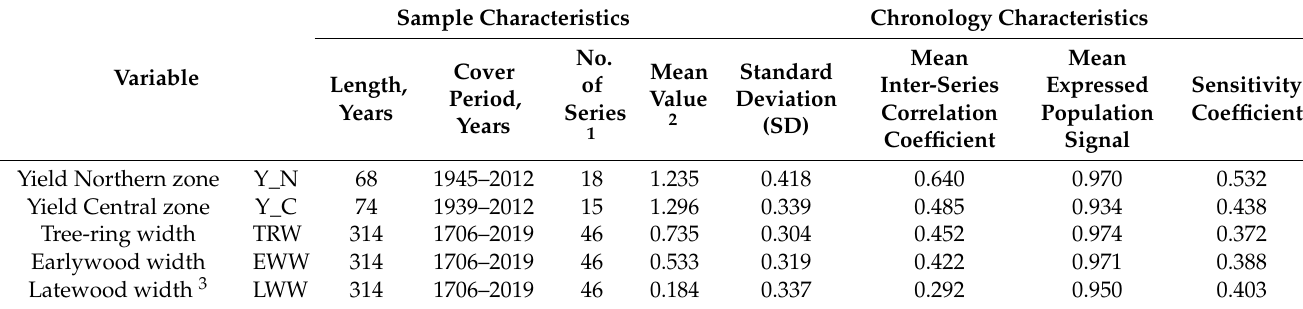
Table 1. Statistic characteristics of crops yield and larch tree-ring parameters’ residual chronologies.